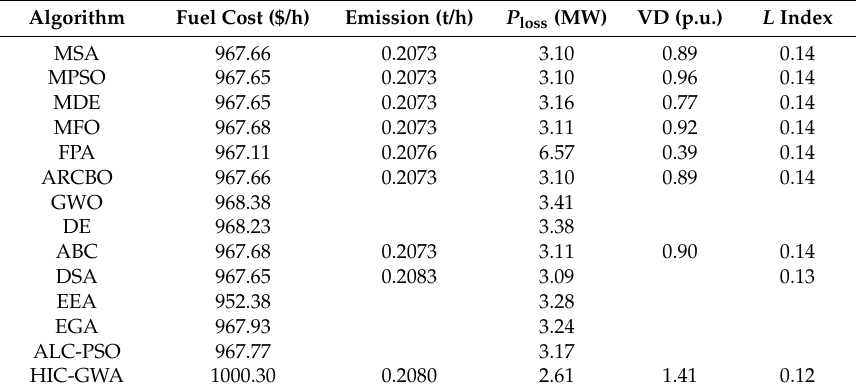
Table 9. Comparison of HIC-GWA solutions with the literature for case study 5.